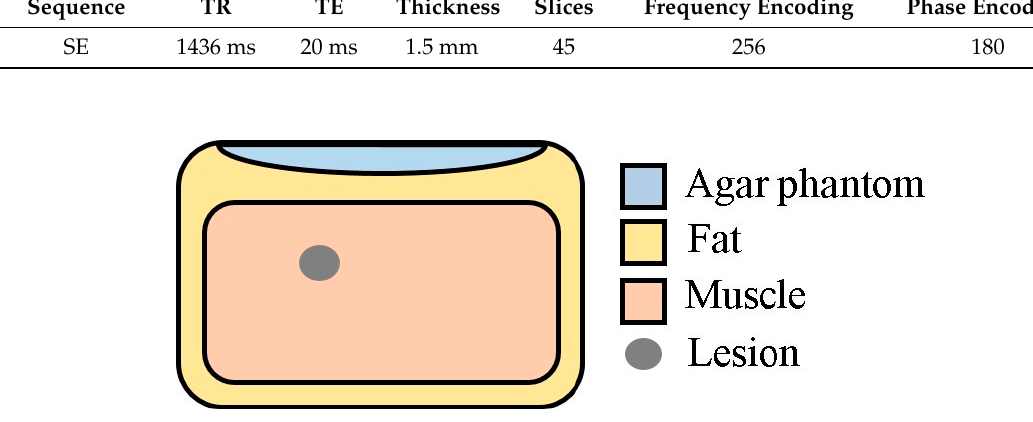
Table 4. MRI scan parameters for the abdominal phantom and human neck.